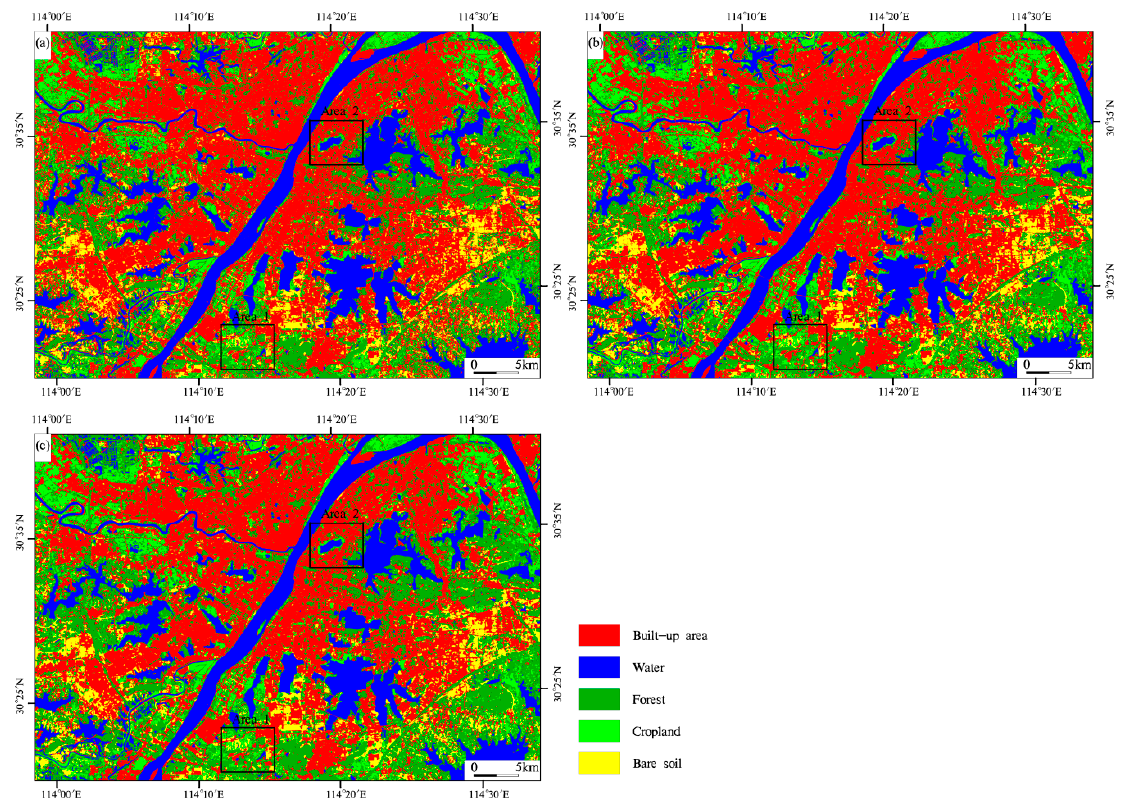
Figure 7. Land cover classification results using Sentinel-2B MSI image alone with the SVM-CK algorithm ( a ), the SVM algorithm ( b ), and the KELM-CK algorithm ( c ).